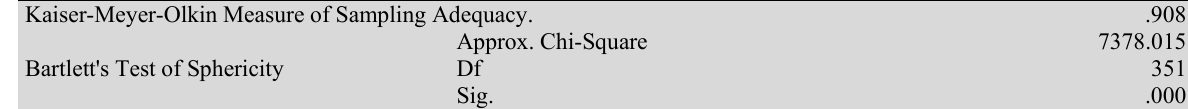
Total Variance Explained Compo- Initial Eigenvalues Extraction Sums of Squared Loadings Rotation Sums of Squared Loadings nent Total